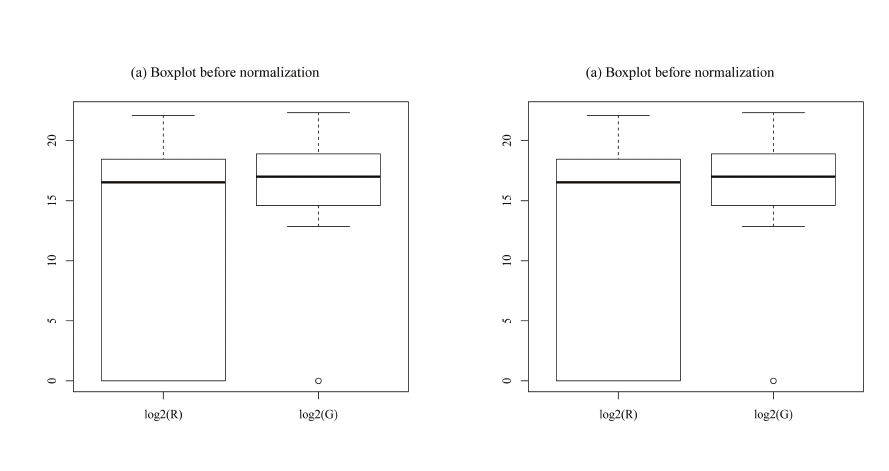
Figure 2 { Box plots of intensities from microarray Experiment NT 2 3 (a) Before nor- malization, (b) After loess normalization.